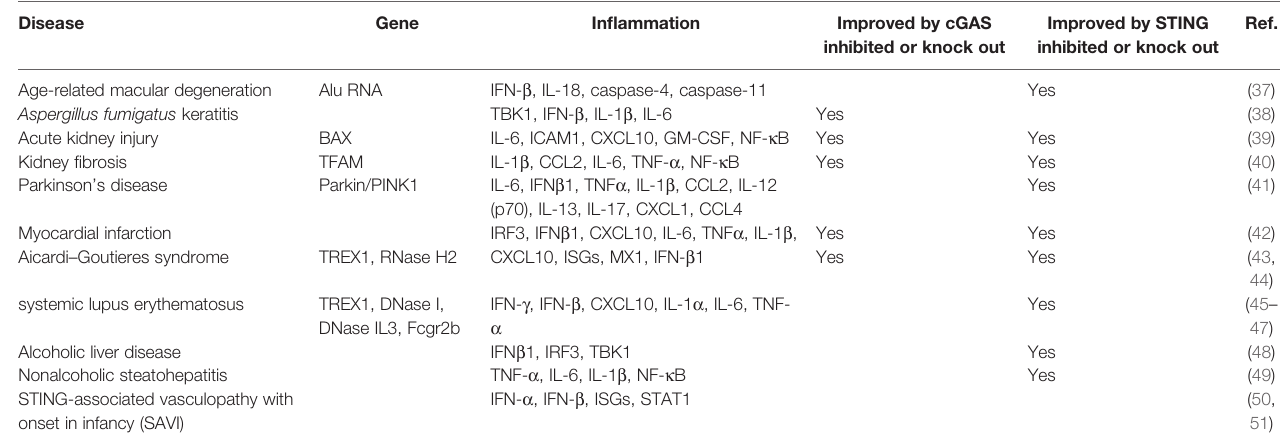
TABLE 1 | In fl ammation disease links to cGAS-STING pathway. Disease Gene In fl ammation Improved by cGAS